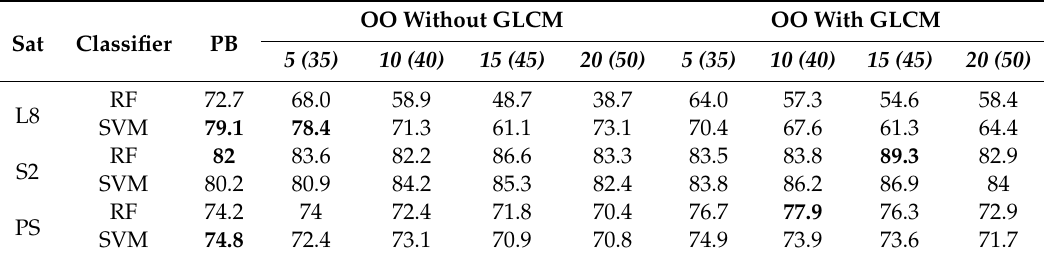
Table 3. Overall accuracies resulted from the pixel-based (PB) and object-oriented (OO)